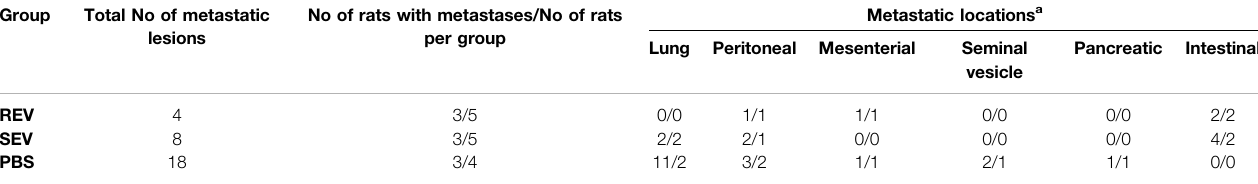
TABLE 3 | Overview of the detected macrometastases in F344 PC model rats.